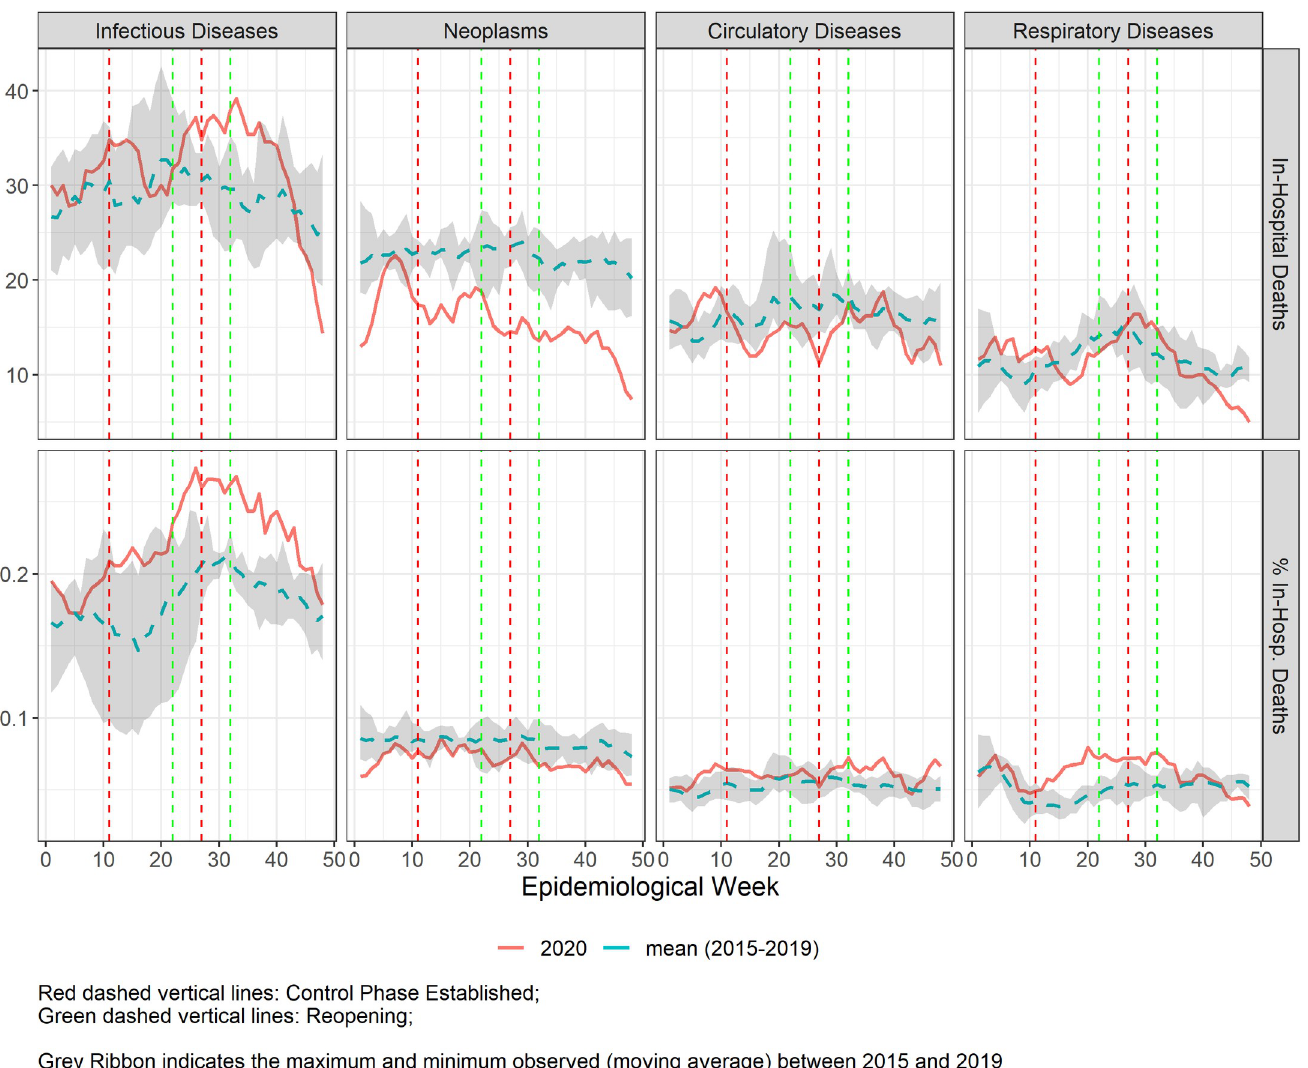
Fig 4. Five-week moving average of number of in-hospital mortality in Belo Horizonte during the COVID-19 pandemic from epidemiological weeks (EW) 1–48, 2020 (solid line), compared to the mean of 2015–2019 (dashed line), for the 4 selected disease groups. Vertical lines refer to the weeks of control (red) and reopening phases